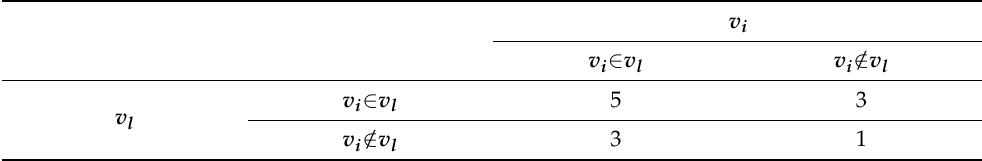
Table 5. Weight according to preconditions between two nodes.